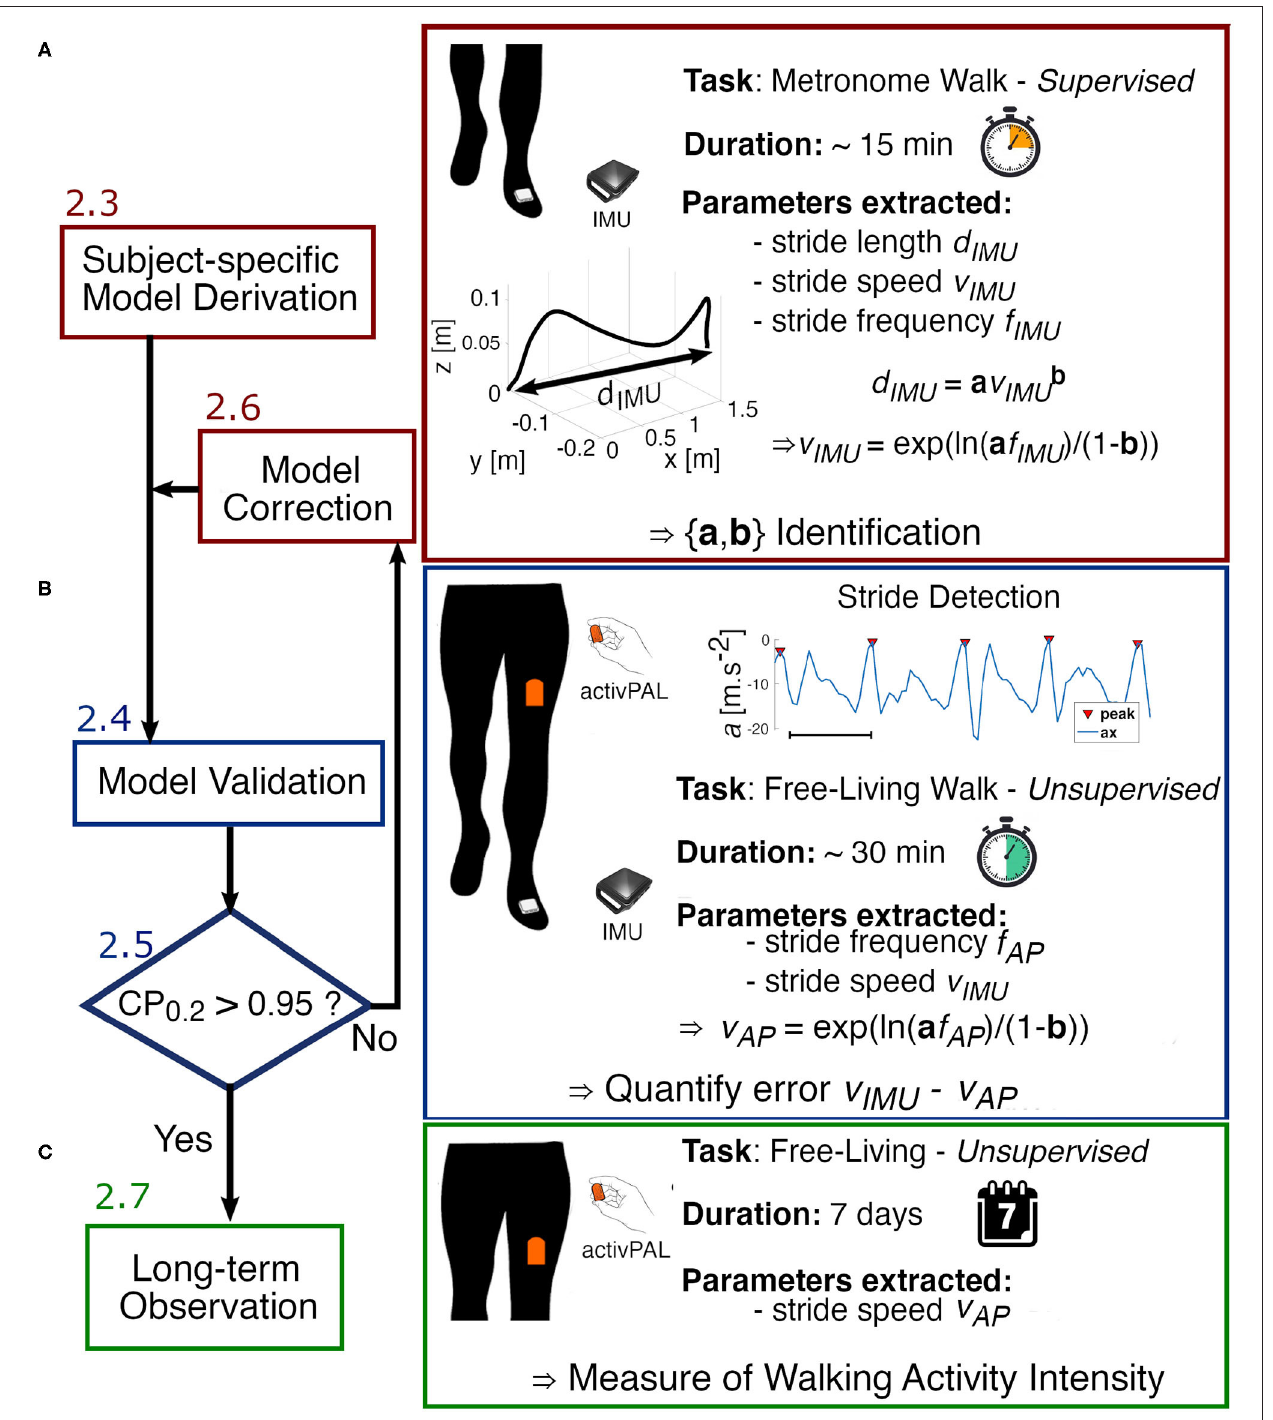
FIGURE 2 | Experimental flow chart. (A) We start by deriving the parameters a and b of the power model using data collected from the IMU worn on the foot during the designed Metronome Walk. (B) To verify the accuracy of the model and validate the identified parameters, each subject performs a long unsupervised walk in the real-world wearing both the activPAL (AP) on the thigh and the IMU on the foot. The error between the estimated speed from the AP and the speed extracted from the IMU is then analyzed. If the error is not clinically acceptable (Coverage probability with boundaries ± 0.2 m · s − 1 CP 0.2 > 0.95), the model is adjusted by finding new parameters a ′ and b ′ . (C) Once the model is validated, we can proceed to a longer observation with the AP only.